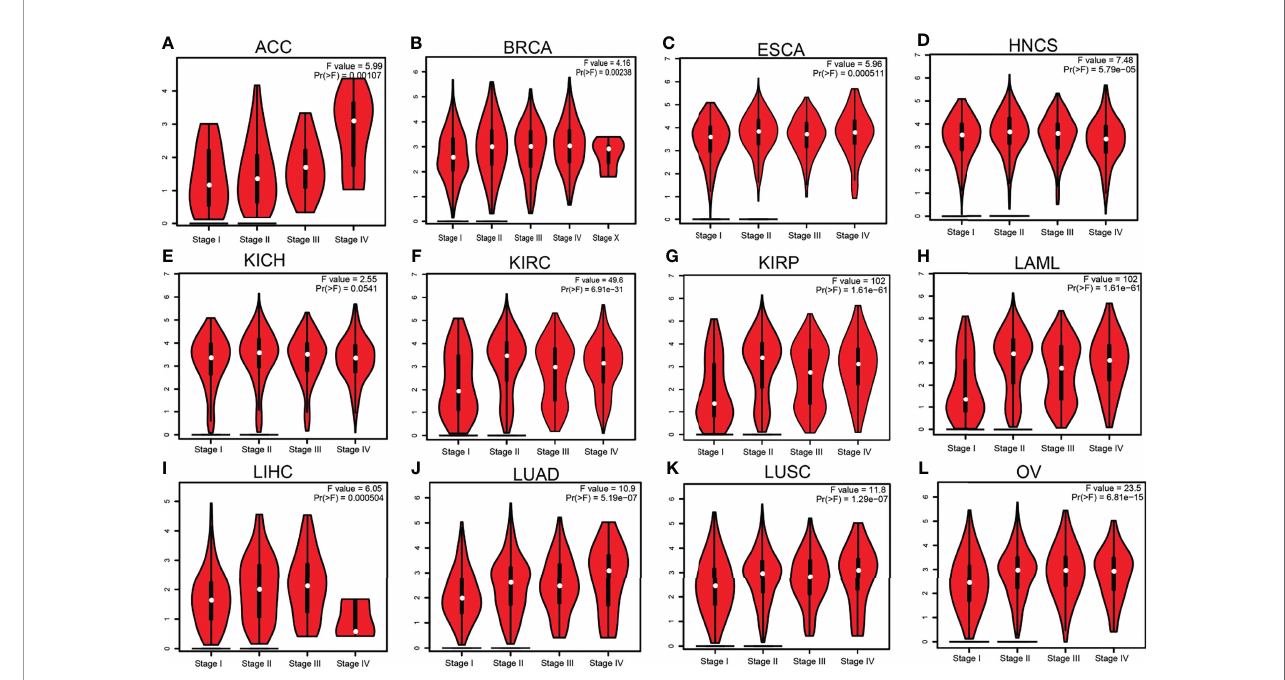
FIGURE 2 | Pathological stage analysis of hyaluronan-mediated motility receptor ( HMMR ) in various human cancers. (A – K) Pathological stage of HMMR in adrenocortical carcinoma (ACC) (A) , breast invasive carcinoma (BRCA) (B) , esophageal carcinoma (ESCA) (C) , head and neck squamous cell carcinoma (HNSC) (D) , chromophobe renal cell carcinoma (KICH) (E) , kidney renal clear cell carcinoma (KIRC) (F) , kidney renal papillary cell carcinoma (KIRP) (G) , acute myeloid leukemia (LAML) (H) , liver hepatocellular carcinoma (LIHC) (I) , lung adenocarcinoma (LUAD) (J) , lung squamous cell carcinoma (LUSC) (K) , and ovarian serous cystadenocarcinoma (OV) (L) examined using Gene Expression Pro fi ling Interactive Analysis